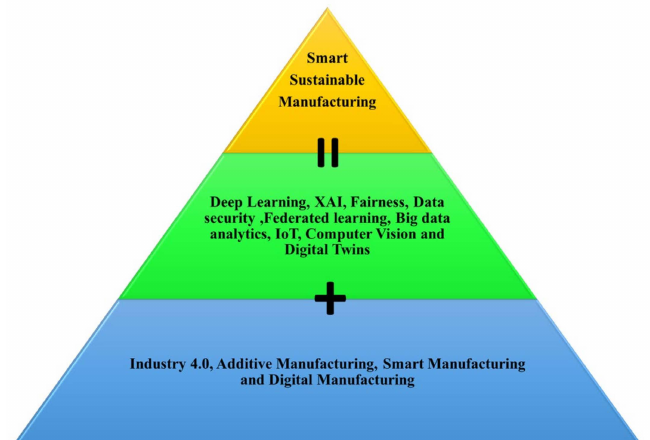
Figure 17. Sustainable pyramid for smart digital